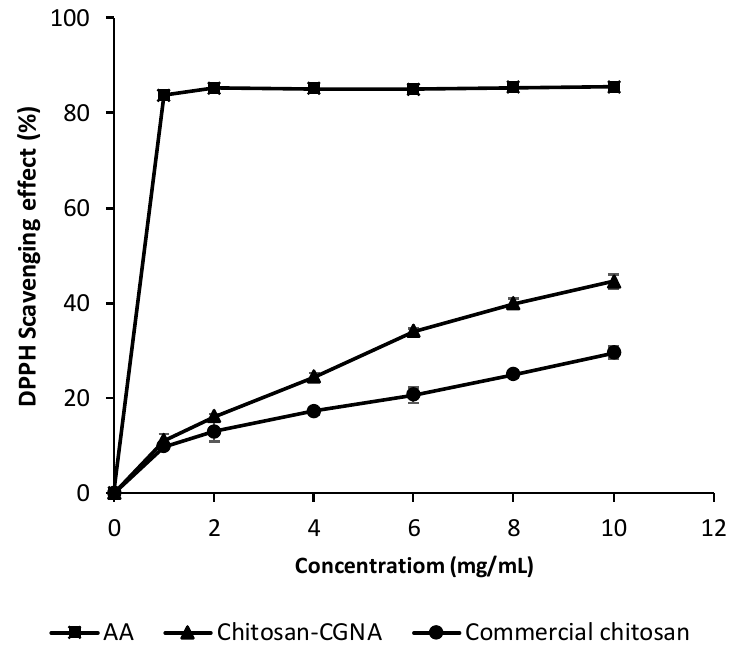
Figure 8. DPPH radical scavenging effect of chitosan samples. Results are presented as means ± standard deviations (n = 3). AA: ascorbic acid.